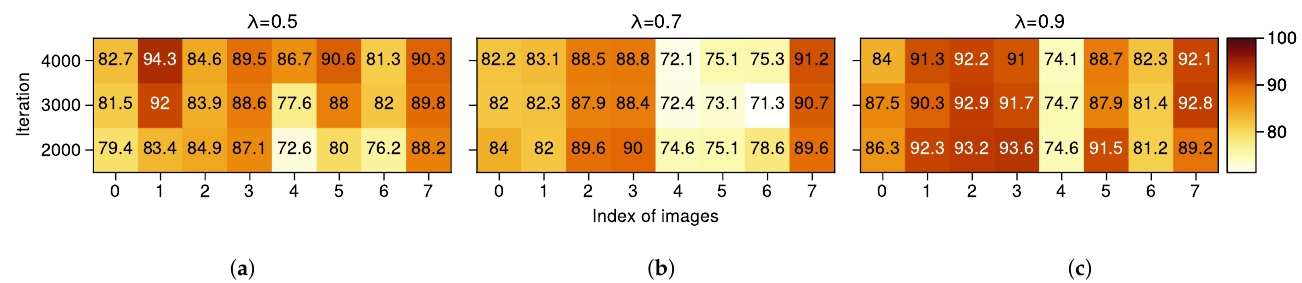
Figure 9. P c : Percentage of correct ones in P h with different threshold λ on POT → VAI, calculated from the same images in Figure 8. ( a ) λ = 0.5. ( b ) λ = 0.7. ( c ) λ = 0.9.